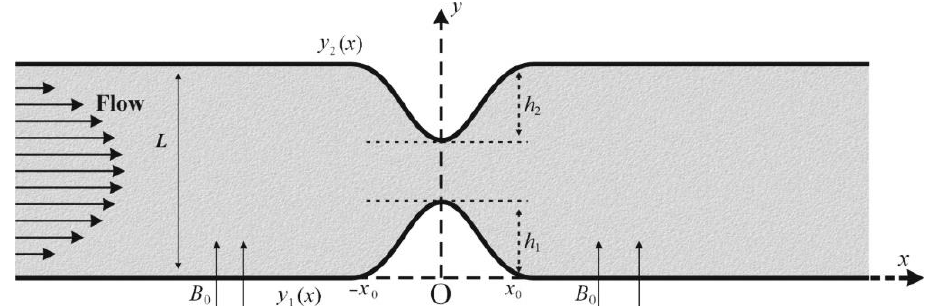
Figure 1. Constricted channel geometry.